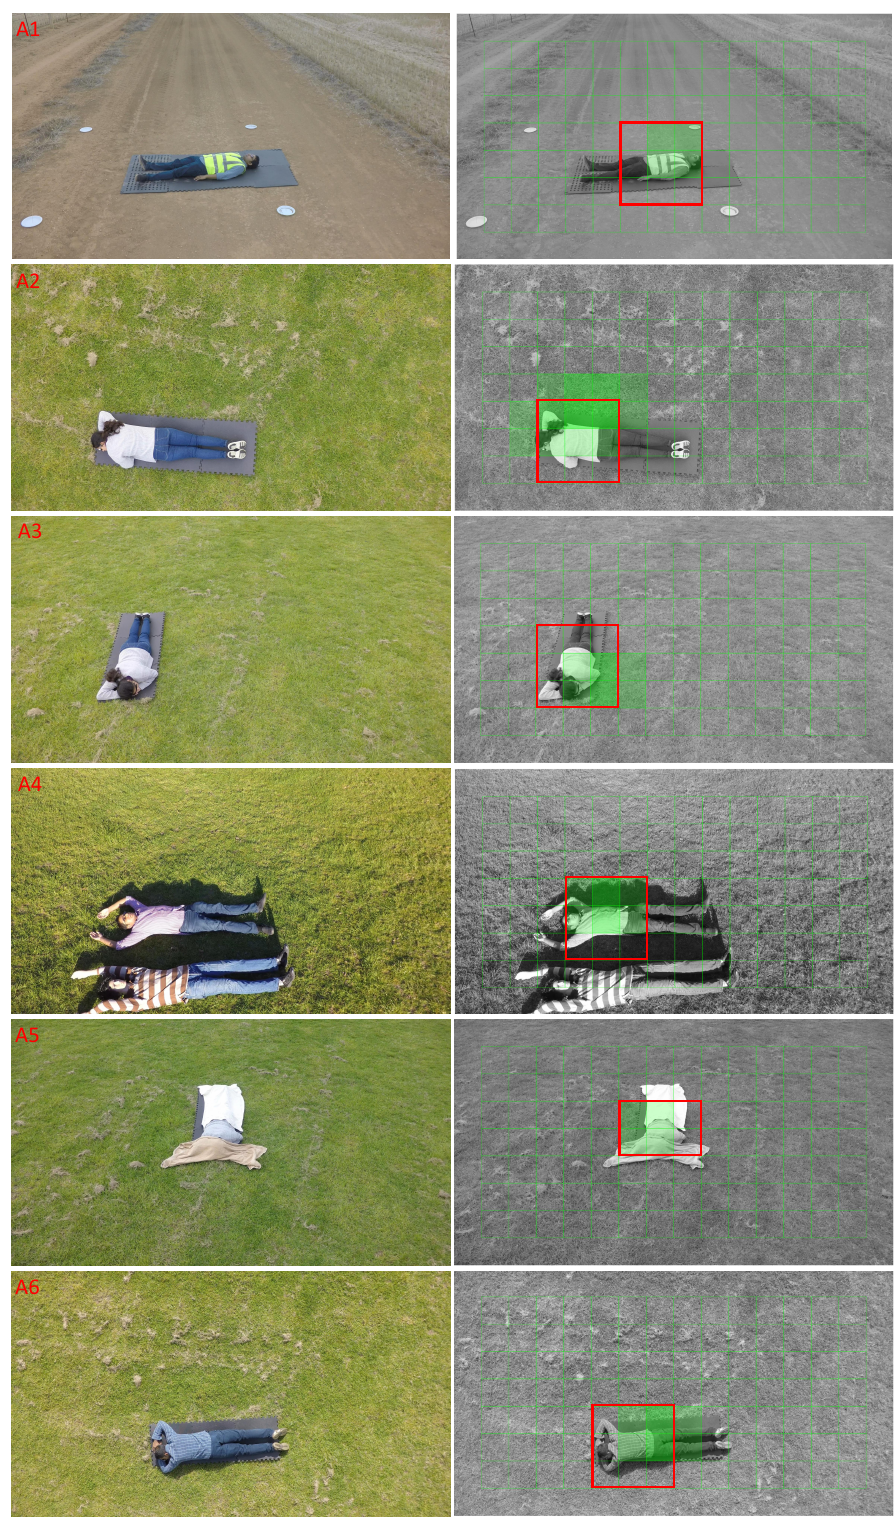
Figure 6. The first column of the images are the first frames of each aerial video (A1–A6). Aerial videos A7–A10 are shown in Figure 7. The second column of images show their localization maps drawn over the first frame. Ground truth bounding boxes are shown in red. Detected bounding boxes are colored